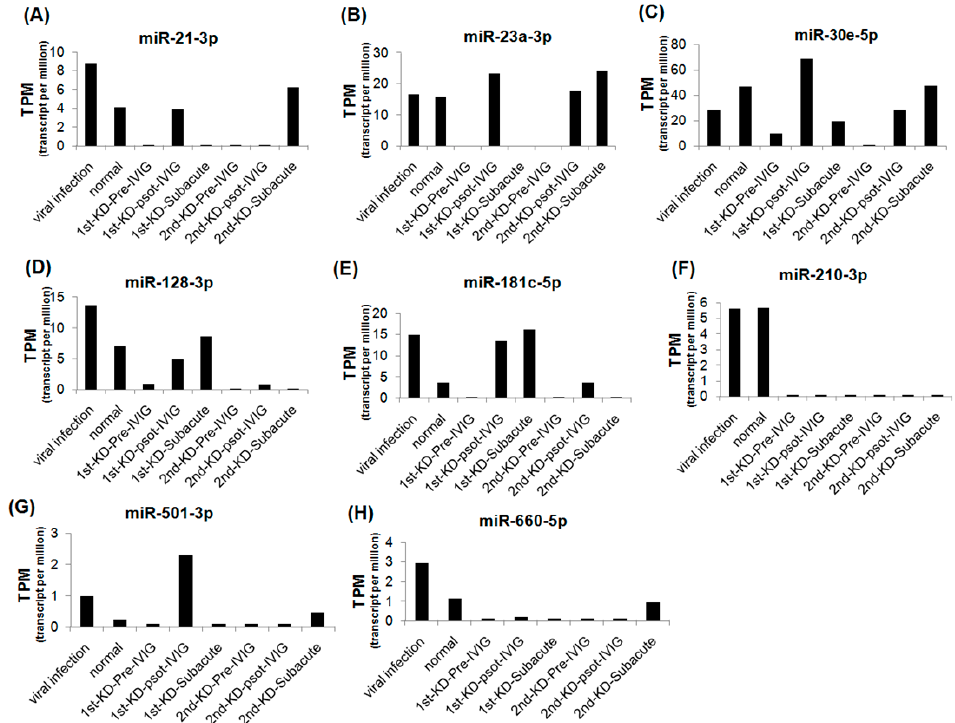
Figure 4. Expression levels of eight downregulated miRNAs in recurrent KD at different stages. The expression levels of miR-21-3p ( A ), miR-23a-3p ( B ), miR-30e-5p ( C ), miR-128-3p ( D ), miR-181c-5p ( E ), miR-210-3p ( F ), miR-501-3p ( G ), and miR-660-5p ( H ) were analyzed using NGS; miRNA expression levels are presented as TPM.